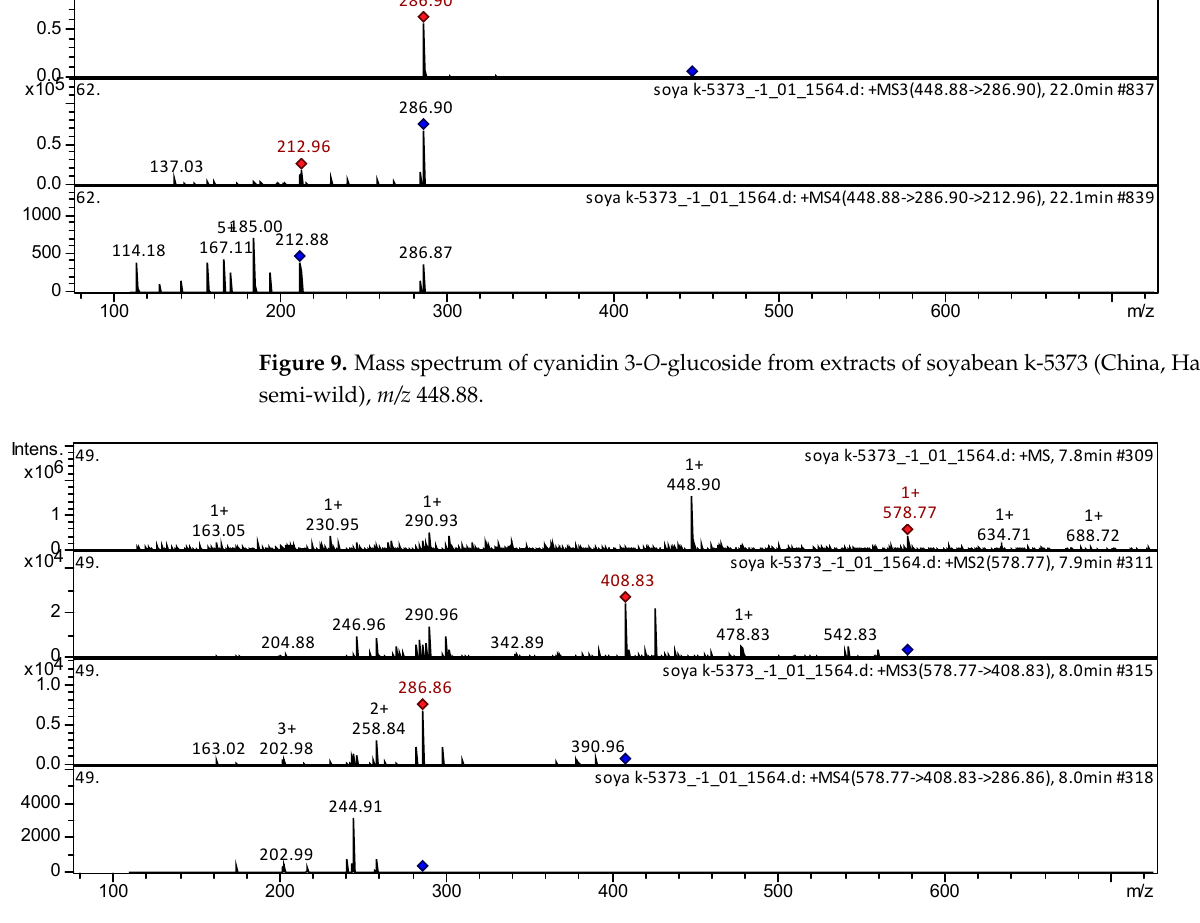
Figure 10. Mass spectrum of proanthocyanidin B1 from extracts of soyabean k-5373 (China, Harbin semi-wild), m/z 578.77.